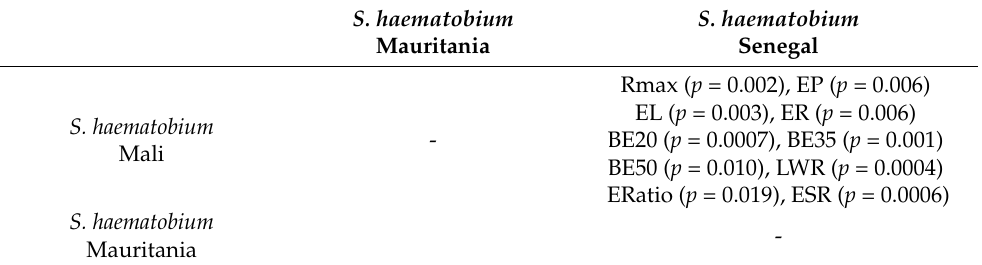
Table 4. Significantly different measurements between S. haematobium eggs compared by the geo- graphical origin of the parasite (Mali, Mauritania and Senegal) by GLMM analysis ( p < 0.05). All models were made, including patient identification, to account for the lack of independence of